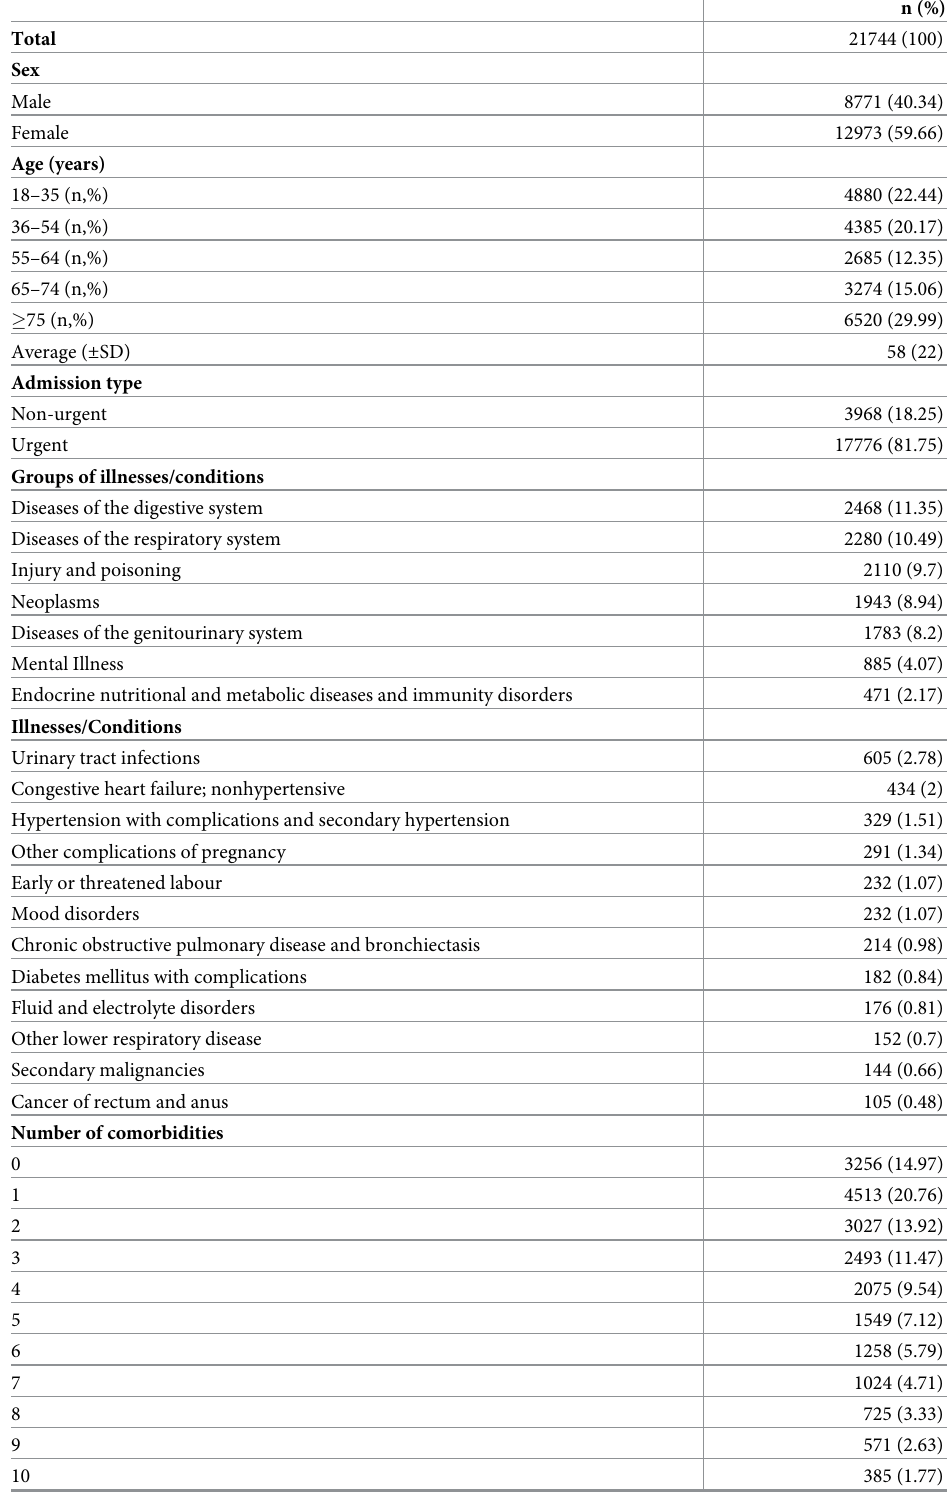
Table 1. Characteristics of included